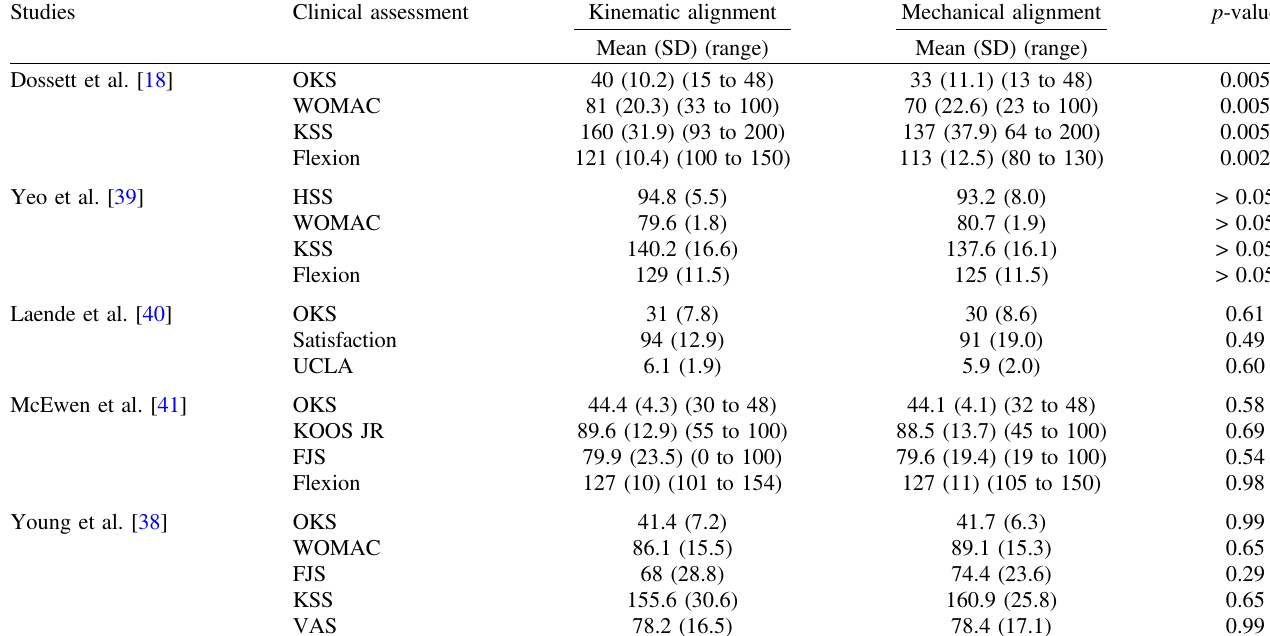
Table 3. Clinical results at the last follow up ( SD = standard